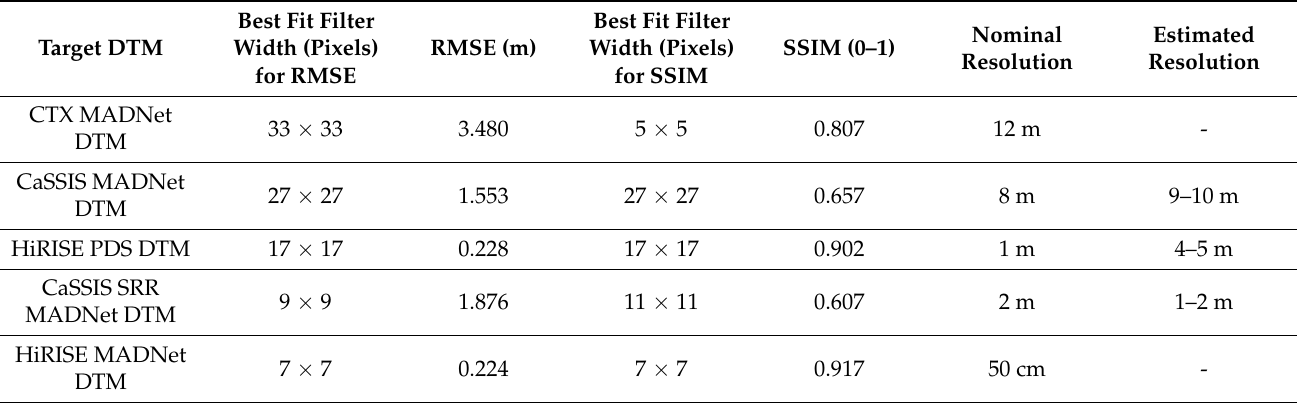
Table 2. Summary of evaluation statistics of the target CTX MADNet DTM [28], CaSSIS MADNet DTM, HiRISE PDS DTM, CaSSIS SRR MADNet DTM, and HiRISE MADNet DTM [28], with respect to the reference 12.5 cm/pixel HiRISE SRR MADNet